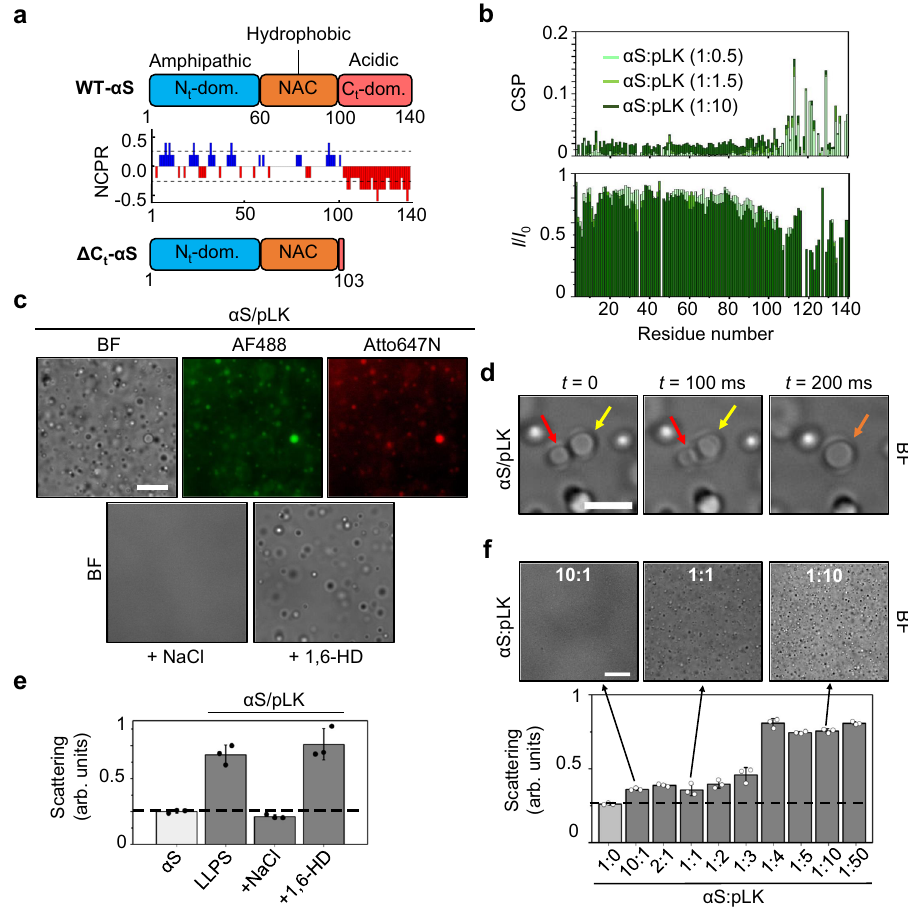
Fig.1|Complexelectrostaticcoacervationof α Swithpoly-L-lysine.a Schematic of the different proteinregions inWT- α S and the Δ C t - α S variant used inthisstudy. The amphipathic N-terminal domain, the hydrophobic amyloid-forming (NAC) region and the negatively charged C-terminal domain are shown in blue, orange and red, respectively. The net charge per residue (NCPR) diagram of WT- α S is shown. b NMR analysis of α S/pLK interaction in the absence of macromolecular crowding. Chemical shift perturbation (CSP, top) and intensity ratio ( I / I 0 , bottom) analysis of HSQC spectra of C 13 , N 15 -labeled α S (150 μ M) in the presence of increasing concentrations of pLK ( α S:pLK molar ratios of 1:0.5, 1:1.5 and 1:10 are showninlight green, green and darkgreen, respectively). c Bright fi eld(BF,top left and bottom images) and wide fi eld fl uorescence (WF, top center and right images) microscopyimagesof α S/pLKcoacervates(1:10molarratio)atan α Sconcentration of25 μ M(1 μ MAF488-labeled α SorAtto647N-labeled pLKforWFimaging)inLLPS